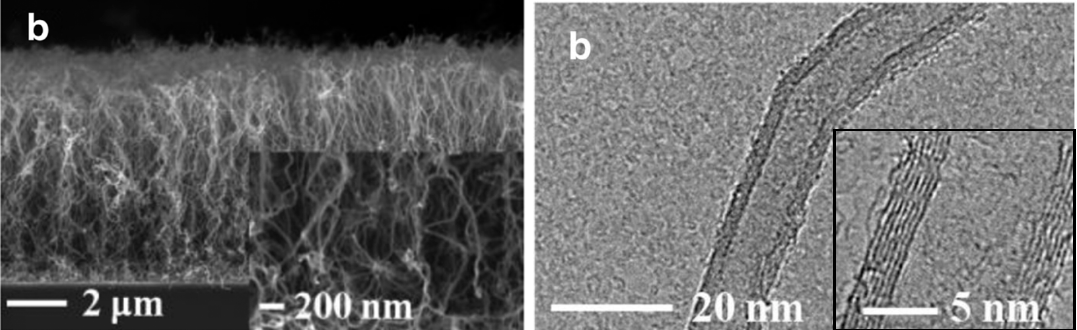
Figure 15. VACNT grown on TiO 2 DBL at 650 °C, where: ( a ) presents side-view SEM micrograph of VACNT and ( b ) transition electron microscopy (TEM) of recovered CNT sample (with zoom insert). Modified after [93].